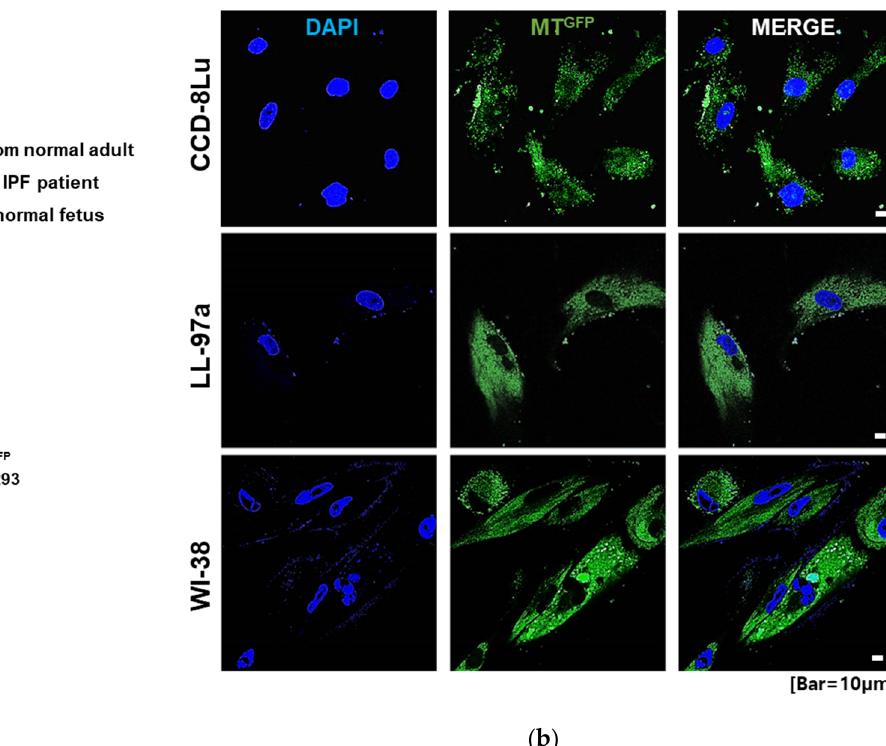
Figure 1. Transplantation of MTGFP into human lung fibroblasts. ( a ) Schematic diagram of human fibroblast monoculture and MTGFP treatment. ( b ) Representative immunofluorescence images of each fibroblast. Cell nuclei were stained with DAPI. MTGFP were successfully transplanted into human lung fibroblasts, including the human lung fibroblast CCD-8Lu, the human lung diploid fibroblast WI-38, and the idiopathic pulmonary fibrosis patient-derived human lung fibroblast LL97A. Scale bar: 10 μ m.